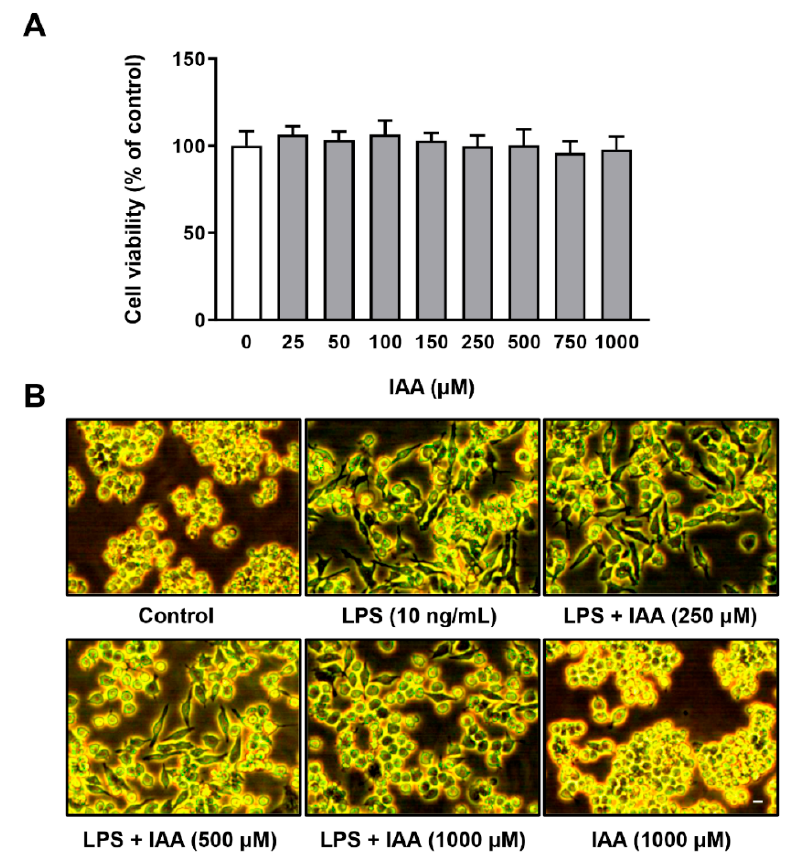
Figure 1. Effects of IAA on cell viability of RAW264.7 macrophages. ( A ) Dose-dependent effect of IAA on cell viability of the RAW264.7 macrophages. Cells were treated with multiple dose of IAA for 28 h in DMEM supplemented with 5% FBS. Cell viability was determined by CCK-8 assay. Values are given as means ± SEM. n = 6. ( B ) IAA blocked the morphological alterations of RAW264.7 cells induced by LPS in dose-dependent manner. Cells were pretreated with various concentrations of IAA as indicated for 12 h, followed by LPS (10 ng / mL) exposure for another 12 h with or without IAA. Images were captured using a phase contrast microscope. Scale bar represents 10 µ m. IAA, indole-3-acetic acid; LPS, lipopolysaccharide; CCK-8, cell counting kit-8.